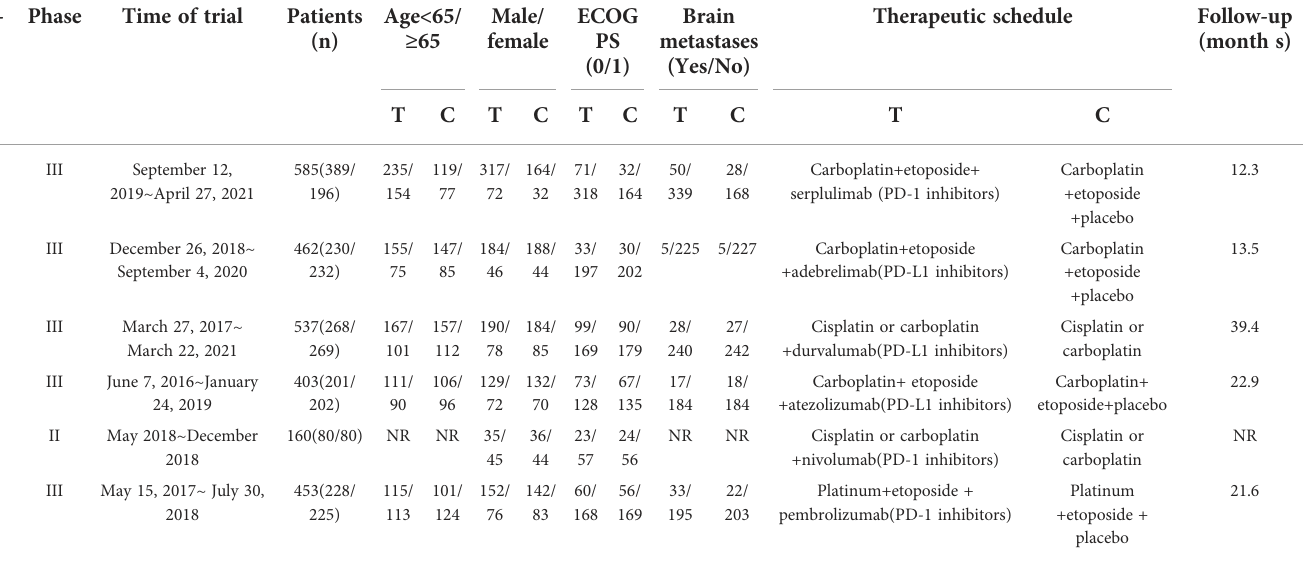
TABLE 1 Characteristics of the included